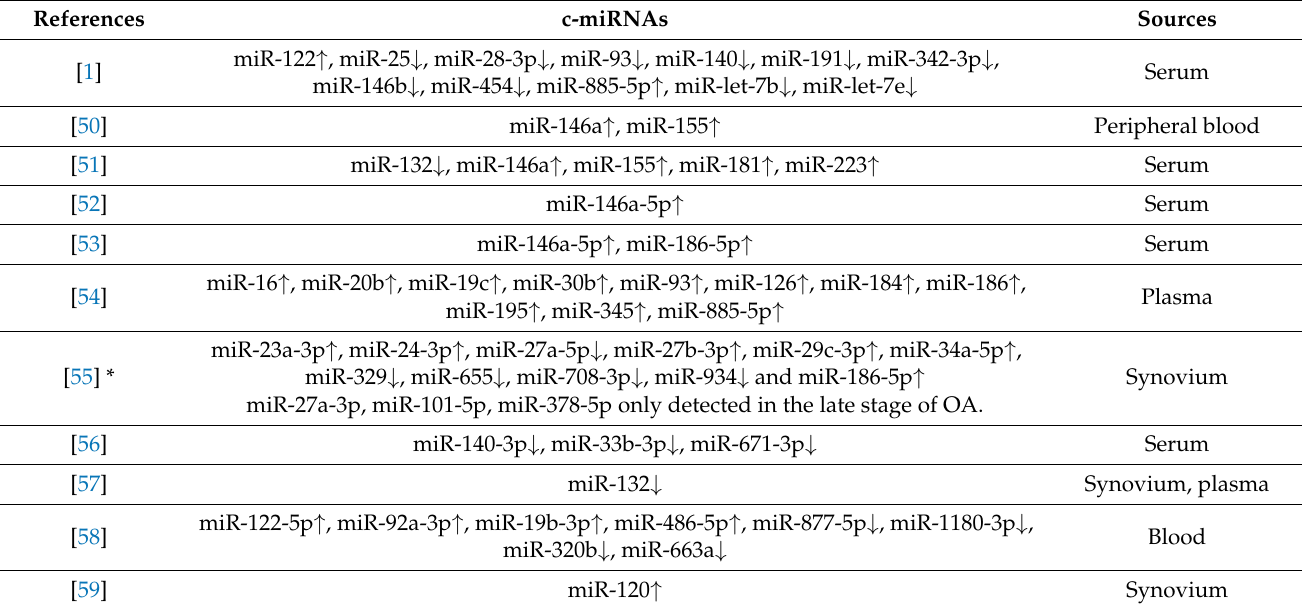
Table 2. The dysregulation of circulating miRNAs (c-miRNAs) in the pathogenesis of